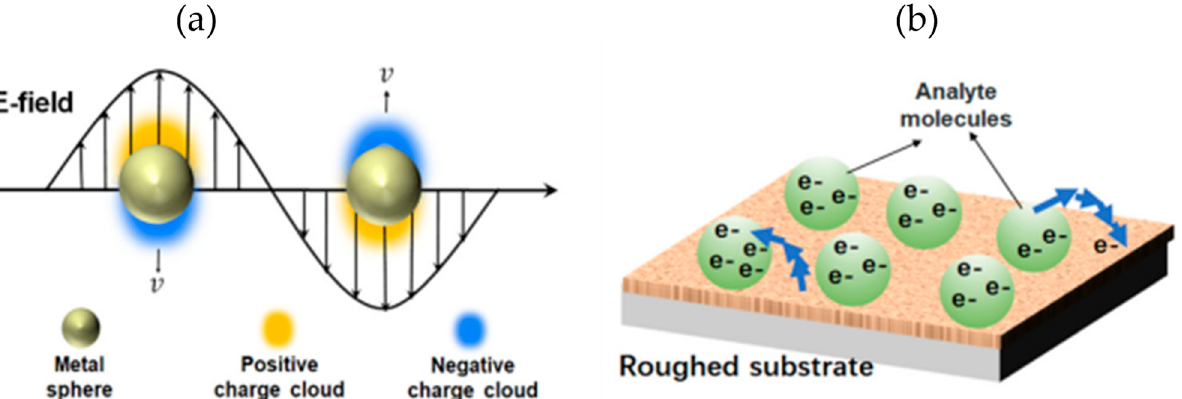
Figure 8. SERS enhancement mechanisms ( a ) EM: surface plasmon resonance on metal surface; ( b ) CM: charge transfer between analyte molecules and roughed substrate. Figure adapted from [59].